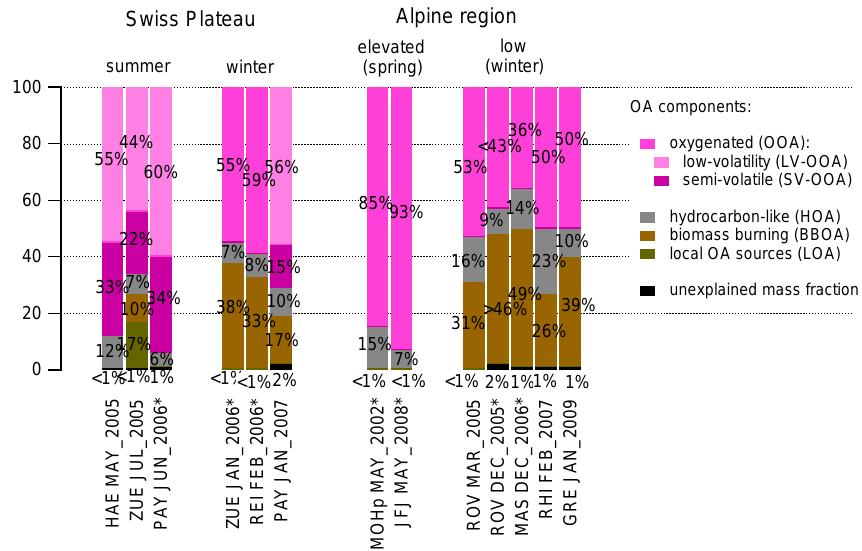
Fig. 3. Relative composition of the organic matter (OM, determined by the AMS instrument): OOA, HOA, BBOA, and local OA (LOA) as determined by factor analysis on organic mass spectra (see Sects. 2.5 and 3.2 for details). The standard deviation of the relative means (%) reported here is typically about 1% or less. The retrievability of the PMF-AMS method ( ∼ 5% OA) and different levels of uncertainties (e.g. number of factors or rotations), however, were found to be often larger than the standard deviations of the resulting OA components (Lanz et al., 2007, 2008; Ulbrich et al., 2009; Allan et al., 2010). In Roveredo, November 2005, a primary wood burning contribution is possibly present in the OOA-factor ( m/z 60 is at about 1% in this latter factor) and, therefore, total BBOA is expected to be higher (“ > 46%”) and SOA (OOA) lower (“ < 43%”) than the averages of the corresponding factors. ? = FA results based on a ME-2 analysis (for details see SI